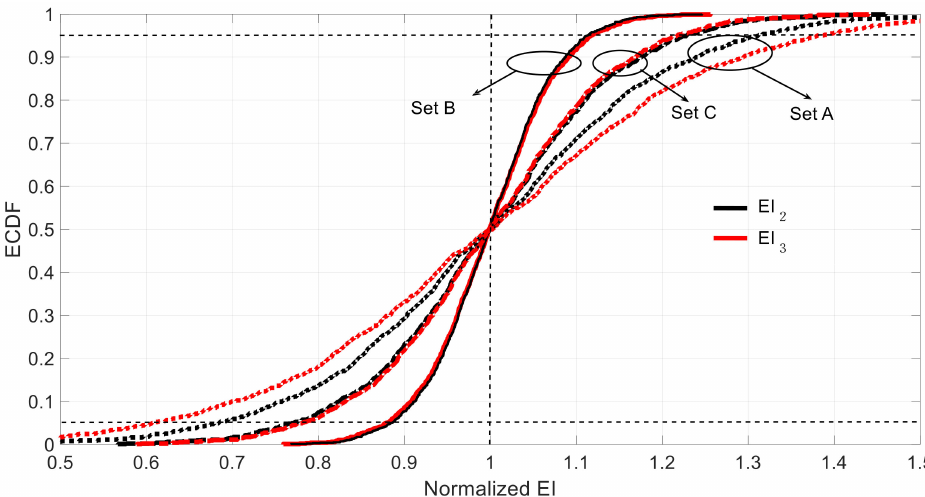
Figure 6. ECDF (empirical cumulative distribution functions) of estimated under different sets considering epistemic uncertainty (the vertical dotted line represents the correct value, and the 5 and 95 percentiles are indicated with horizontal dotted